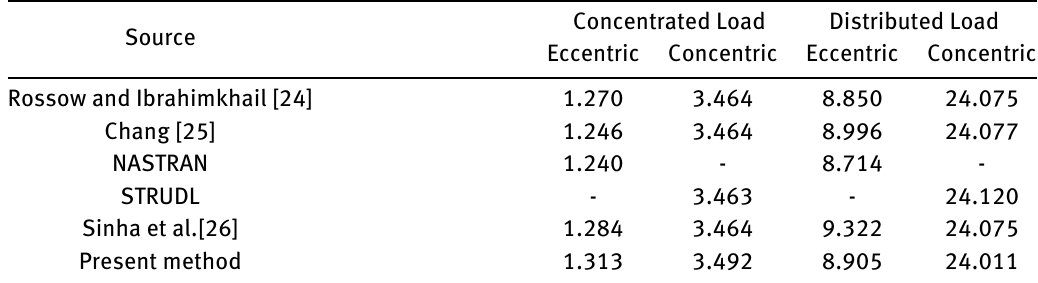
Table 1: Central deflection of rectangular stiffened plate in inches (x 10 3 ).